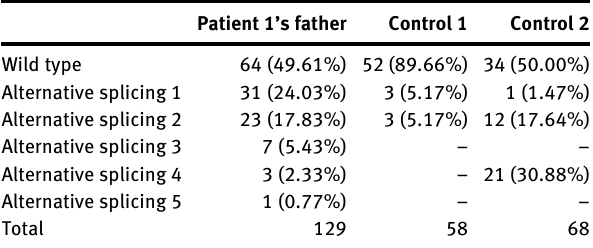
Table  : Numbers and percentages of  TA clones sequencing